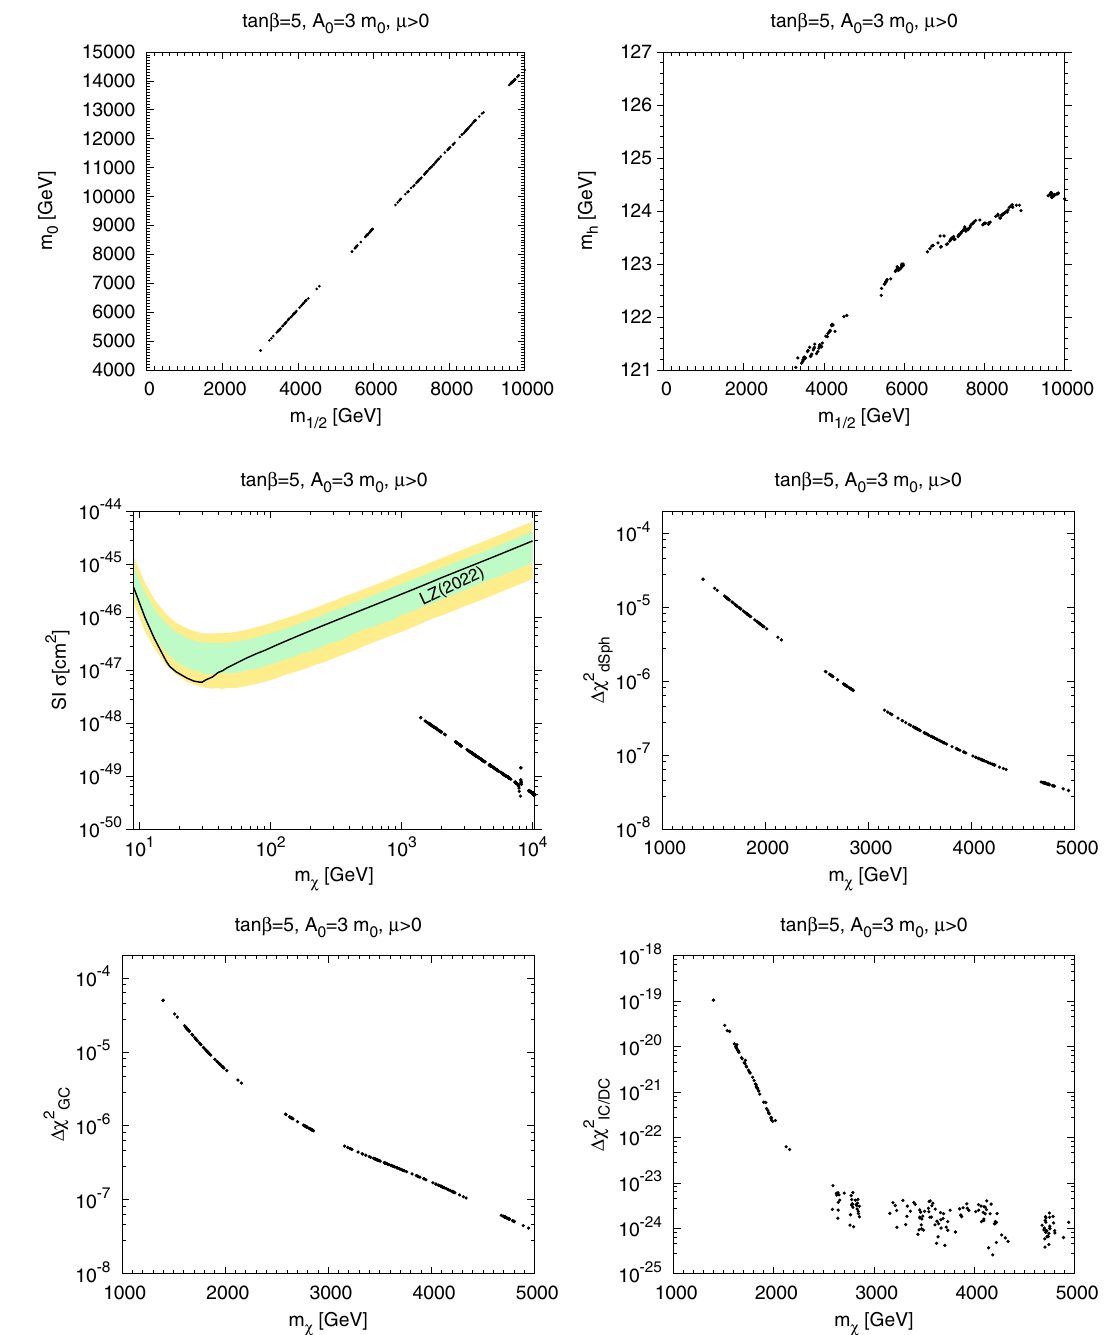
Fig. 16 The dark matter strip, m h constraint, spin-independent direct scattering constraint, (cid:7)χ 2 from Fermi -LAT dSph and H.E.S.S. GC γ -ray and Icecube solar ν signals for the case tan β = 5, A 0 = 3 m 0 and μ >